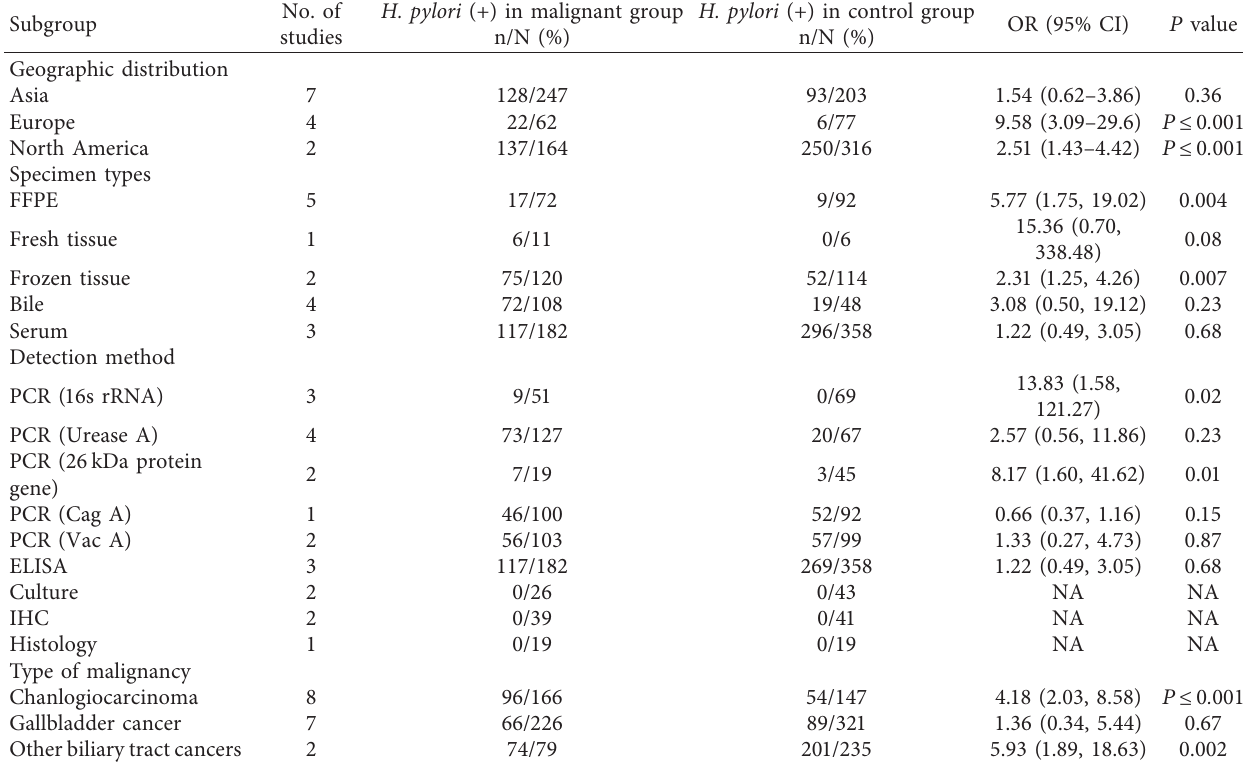
Table 2: Subgroup analysis of H. pylori prevalence in the malignant group compared with the control group.